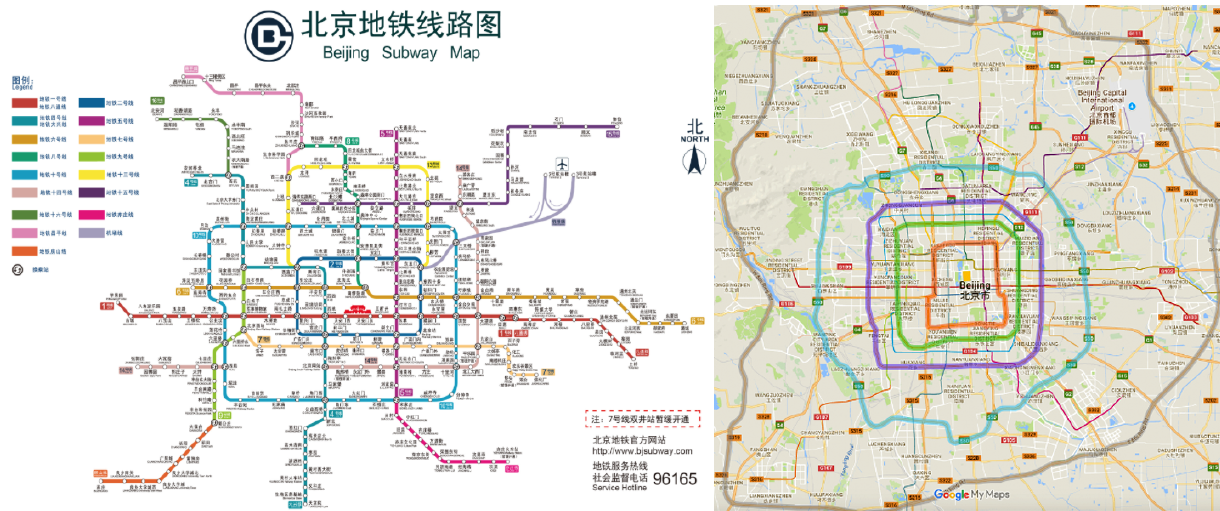
Figure 9. Beijing subway map, updated to 2017 (left), and map of ring roads in Beijing (right). Source: Compiled based on data provided by the Beijing Subway Official Website (2017) and Google